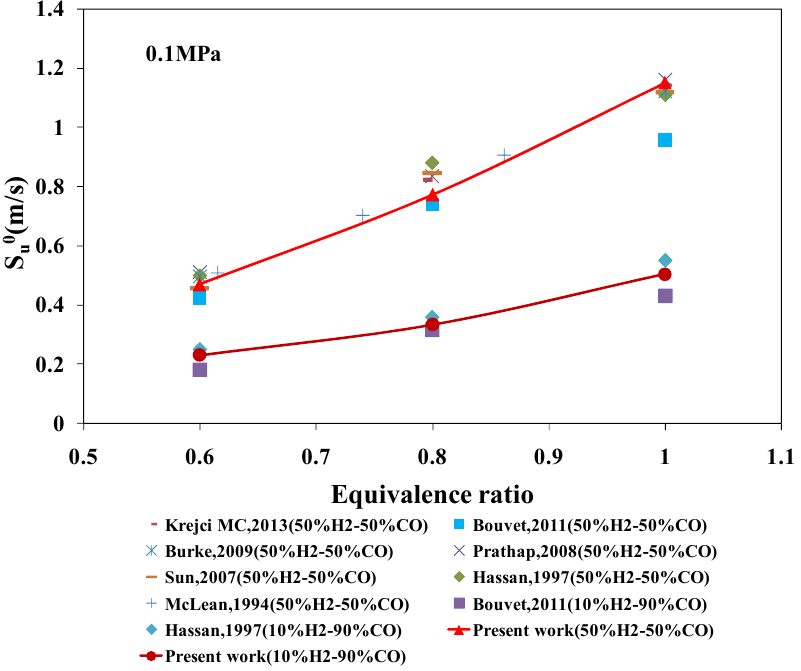
Figure 2. Comparison of measured unstretched laminar burning velocities and